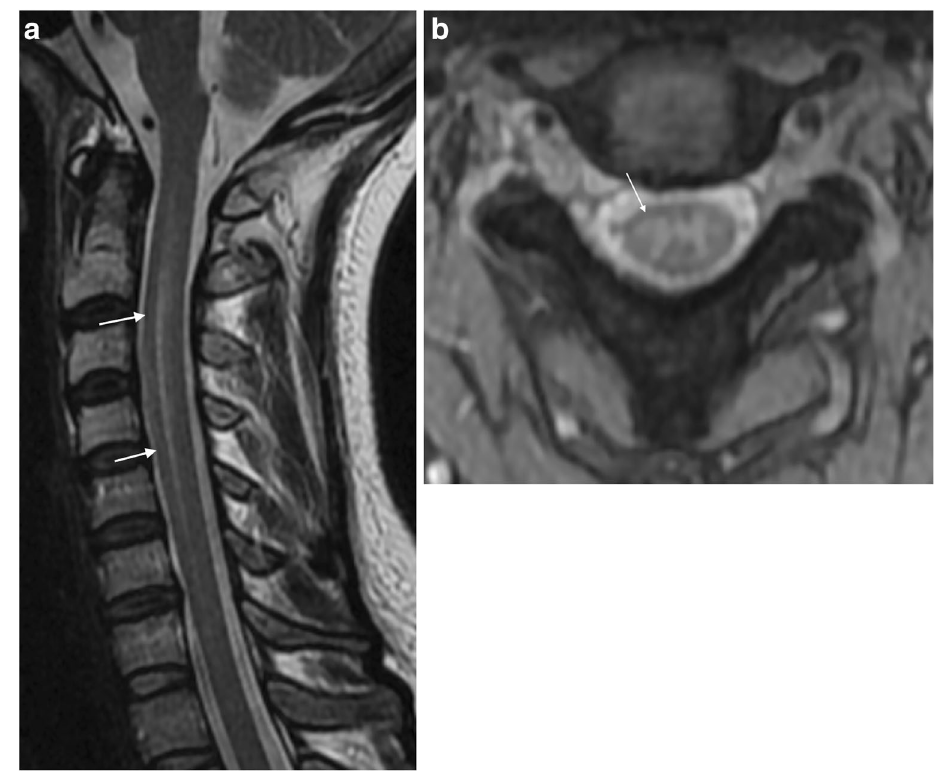
Fig. 3 LNB myelitis in a 35-year old female who presented with pain radiating in the right arm, neck stiffness and general symptoms of headache, fatigue, nausea and vomiting. T2 weighted images showed subtle spinal cord hyperintensity, on sagittal image ( a ) from C2-C5 centrally located (arrows), and on axial T2 gradient echo image at the C2/C3 level ( b ), dominant affection adjacent to the right anterior horn was seen (arrow).